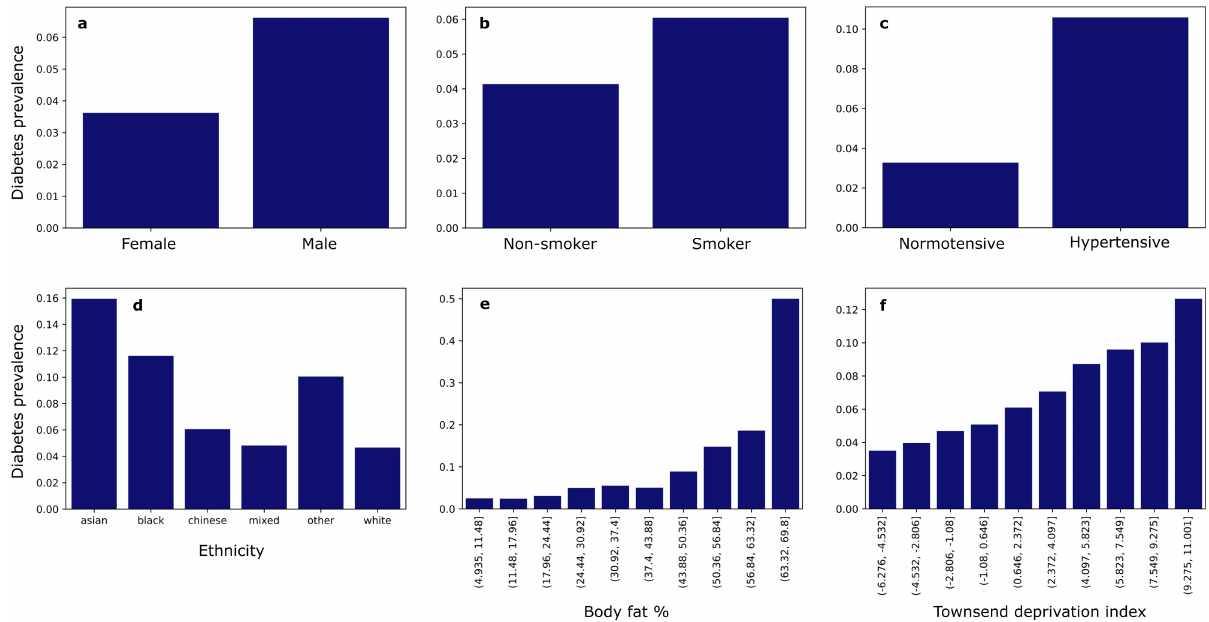
Fig. 2 Diabetes prevalence by variable. Higher prevalence was seen in males ( a ), smokers ( b ), those with high blood pressure ( c ), certain ethnicities ( d ), those with higher body fat % ( e ), and the more deprived ( f